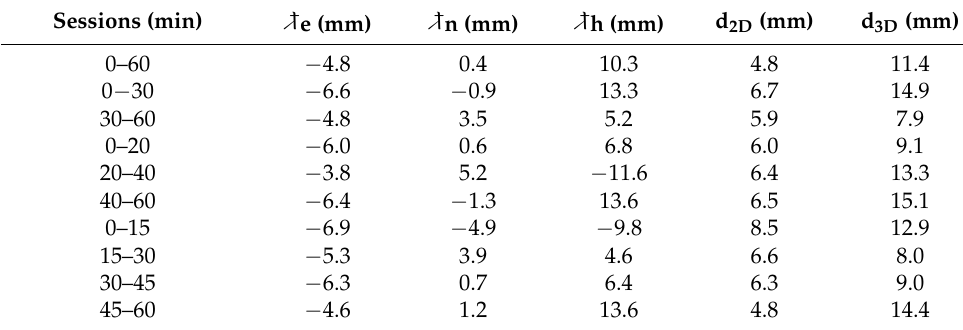
Table 7. Positioning performance results at ST 4.